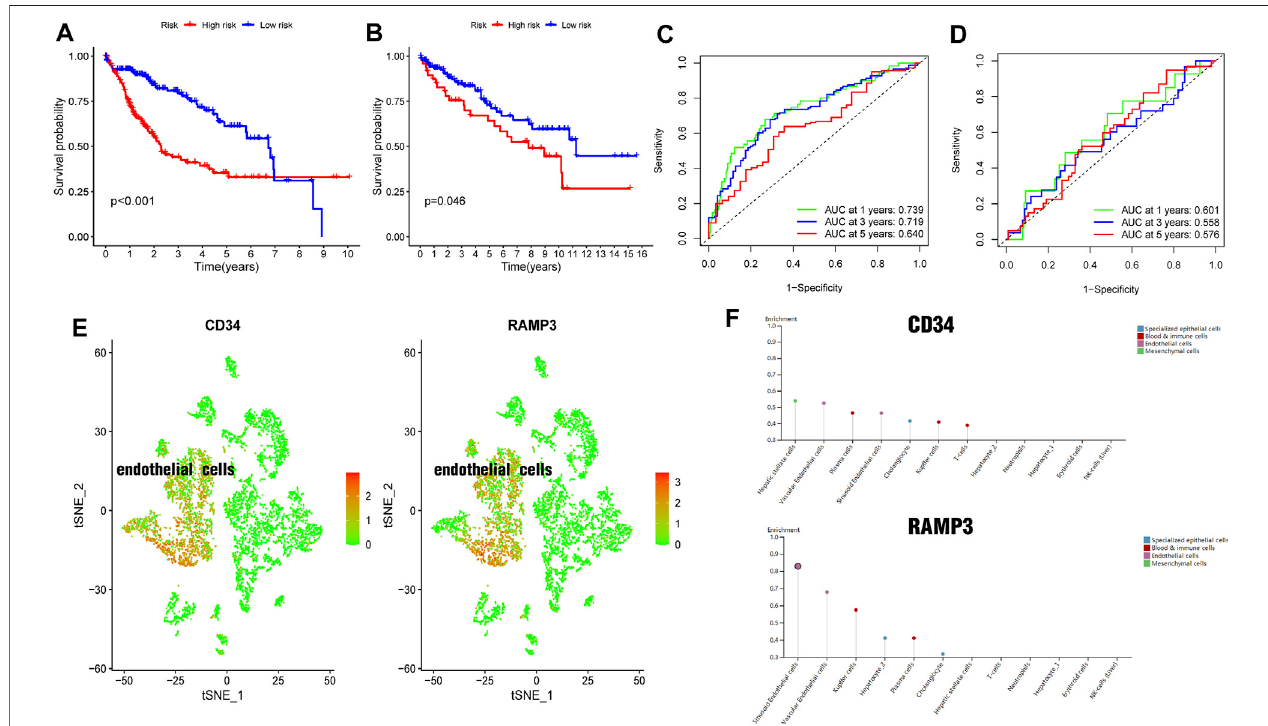
FIGURE 8 | Generation and validation of a prognostic risk scoring signature (A) . Survival analysis between high-risk group and low-risk group in TCGA cohort (B) . Survivalanalysisbetweenhigh-riskgroupandlow-riskgroupinGEOcohort (C) .AreasunderROCcurveoftheTCGAcohorttopredict1-,3-,and5-yearsOS (D) .Areas underROCcurveoftheGEOcohorttopredict1-year,3-years,and5-yearsOS (E) .CD34andRAMP3predominantlyhighlyexpressedinendothelialcells (F) .CD34and RAMP3 expression levels in different liver cells from HPA